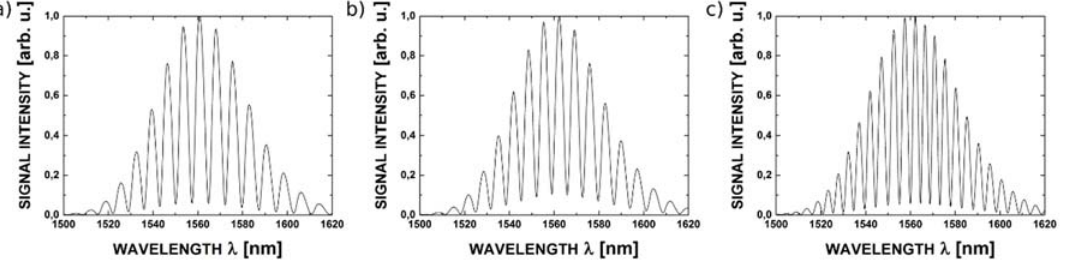
Figure 13. Measurements of different chemical substances, Fabry-Pérot cavity length of 100 µm, at wavelength of 1550 nm: ( a ) reference for clean Ag mirror; ( b ) cyclohexane and ( c ) toluene.